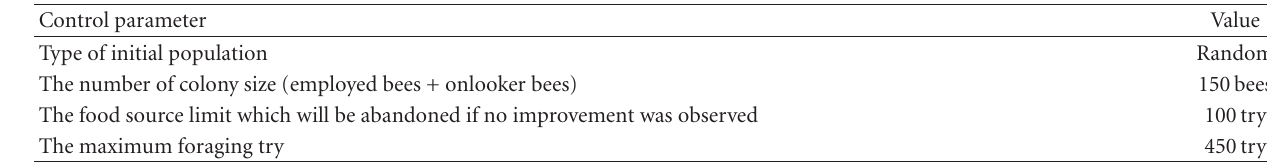
Table 1: Control parameters of ABC algorithm.